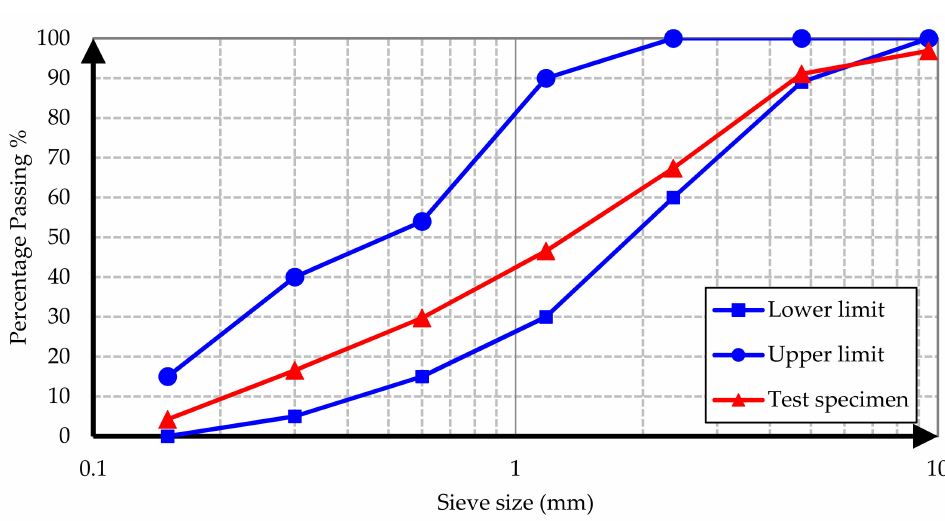
Figure 4. Barite sand sieve analysis grading curve.